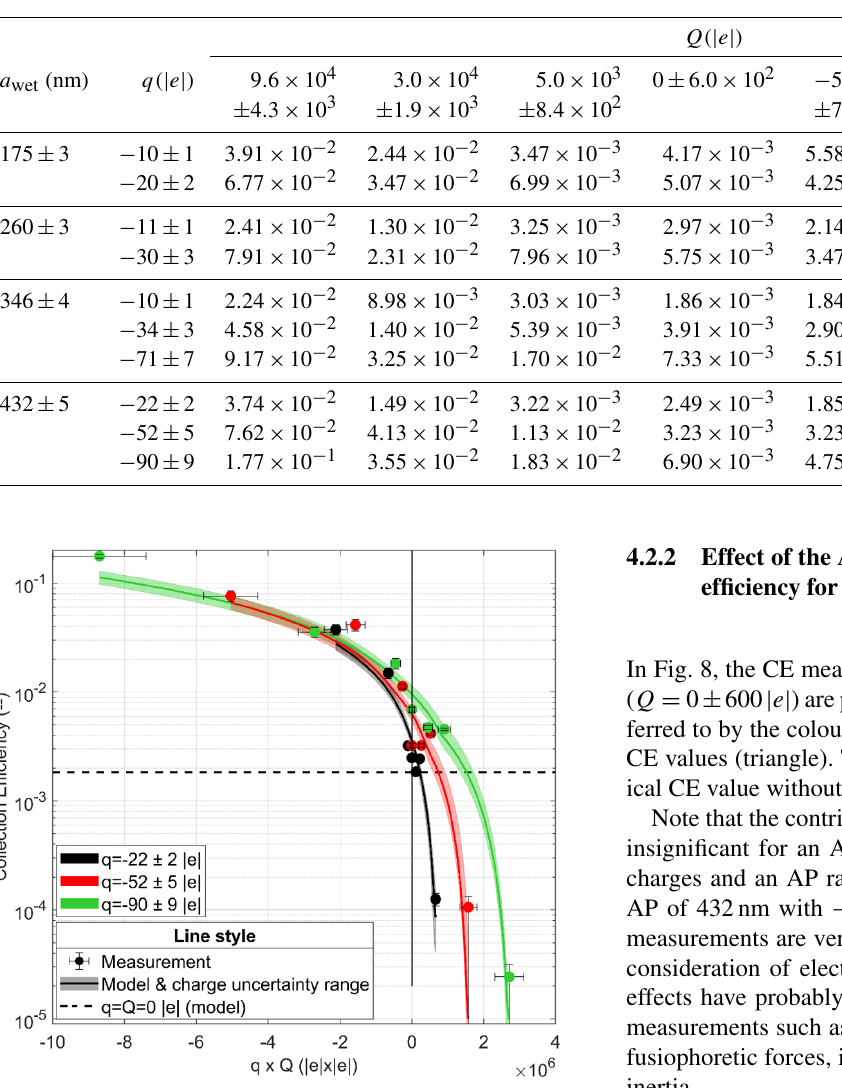
Figure 7. CE measurement as a function of the product of the droplet ( Q ) and AP ( q ) charges for the wet AP radius of 432nm and a droplet radius of 48 . 5 ± 1 . 1µm. The experimental conditions are summarised in Table 5. Colour code informs about the AP charge. The dashed line represents the theoretical CE value disregarding the electrostatic forces (given the air parameters 1 ◦ C, 1atm, 95% of relative humidity). The solid line is the interpolation of the Dépée et al. (2019) extended model (with the charge uncertainty range) for the respective CE measurements at a given AP